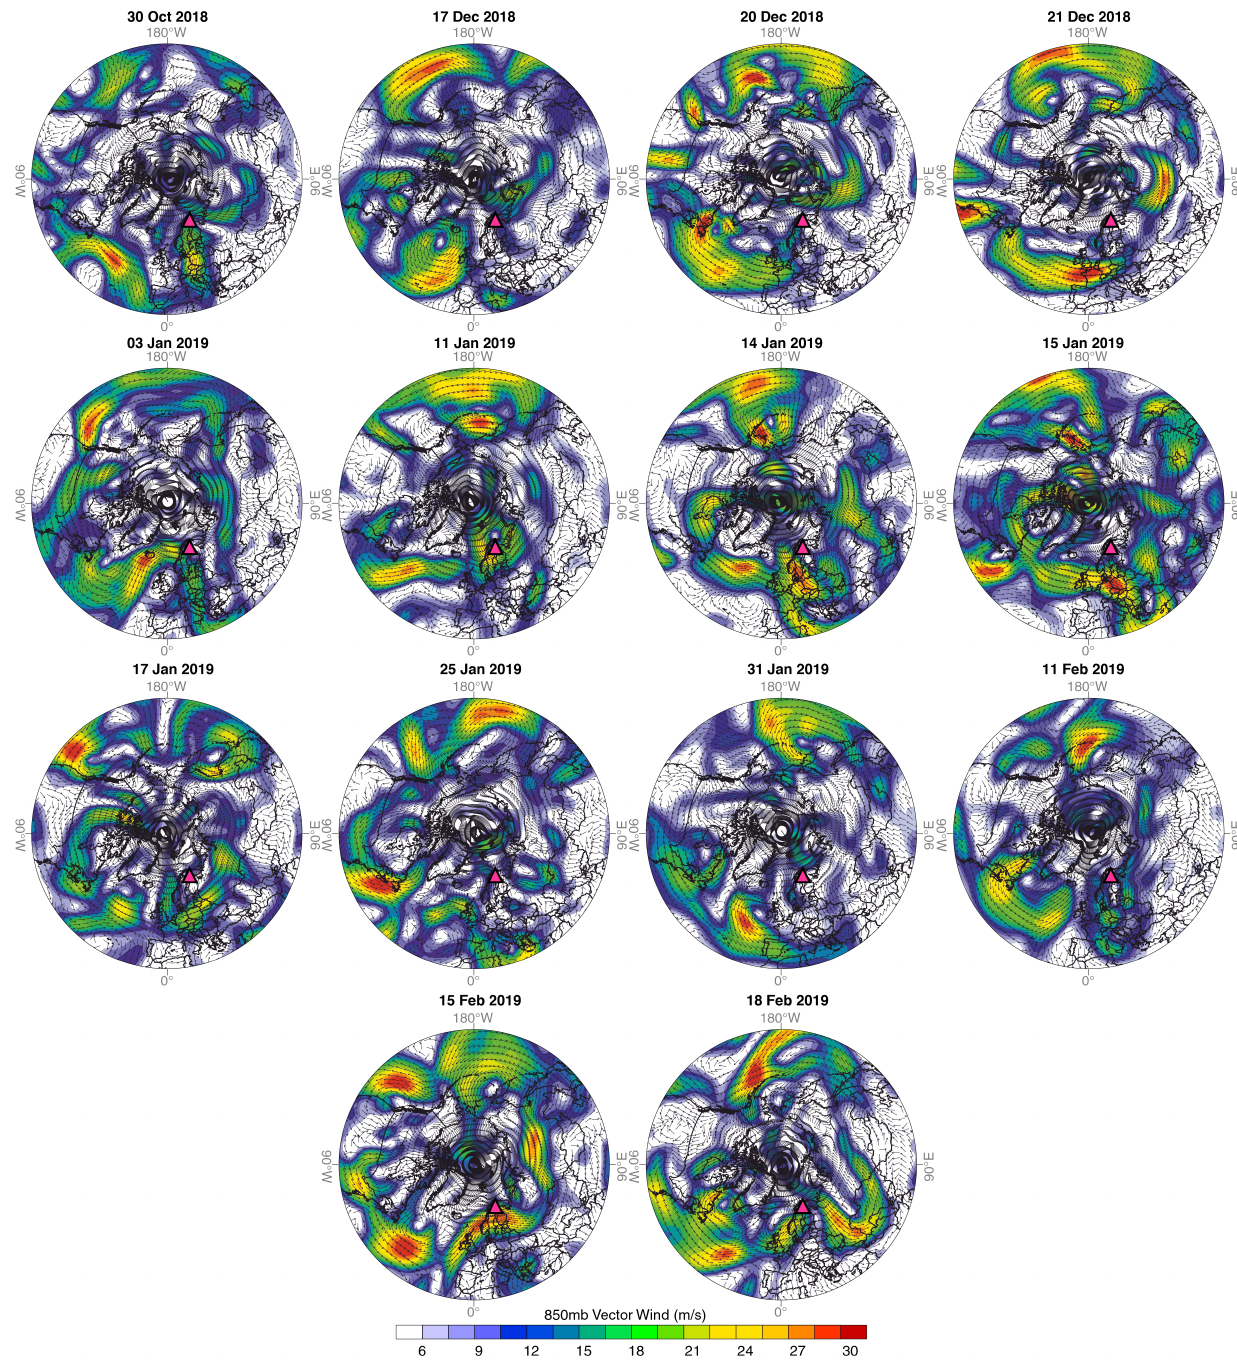
Figure A4. Northern Hemisphere (35 to 90 ◦ N) daily mean 850 mb vector winds during snowfall events sampled at Pallas (triangle) in winter 2018–2019, from NCEP/NCAR reanalysis